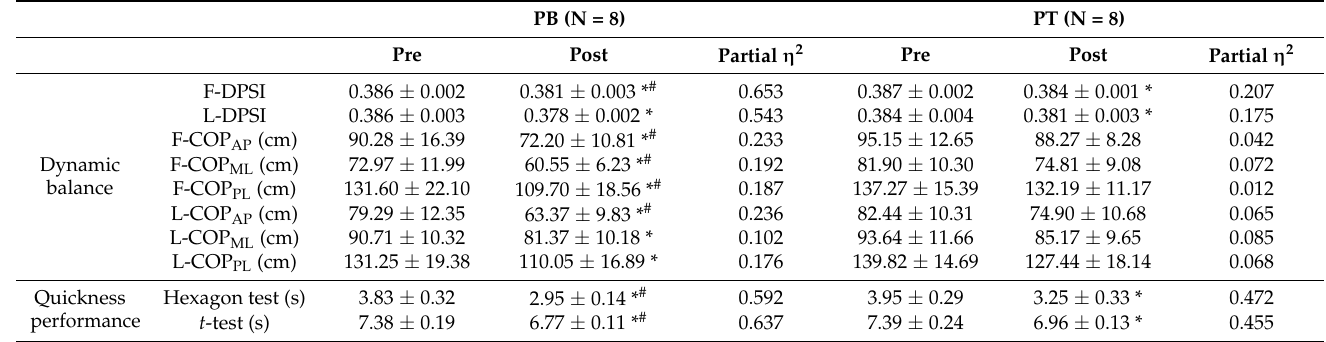
Table 2. The assessment results for PB group and PT group before and after the 6-week